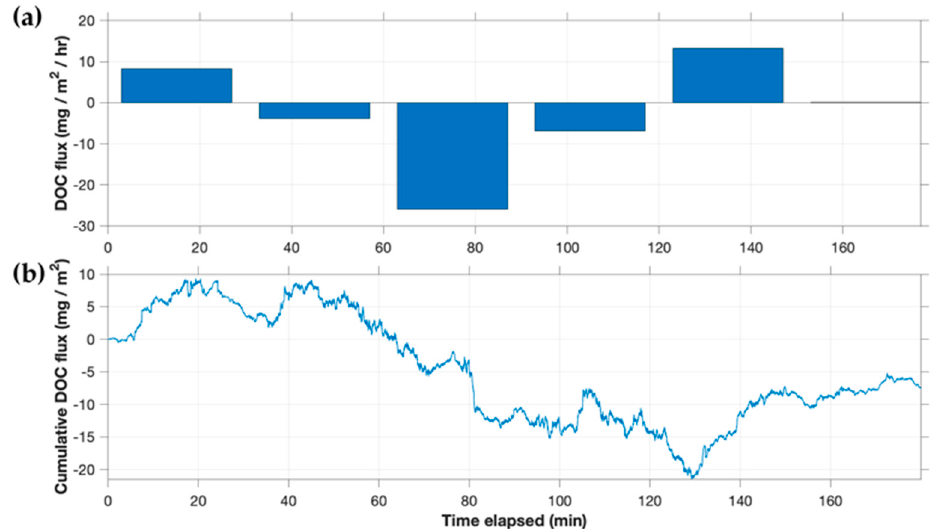
Figure 10. ( a ) DOC flux and ( b ) cumulative flux at Upper Mystic Lake.